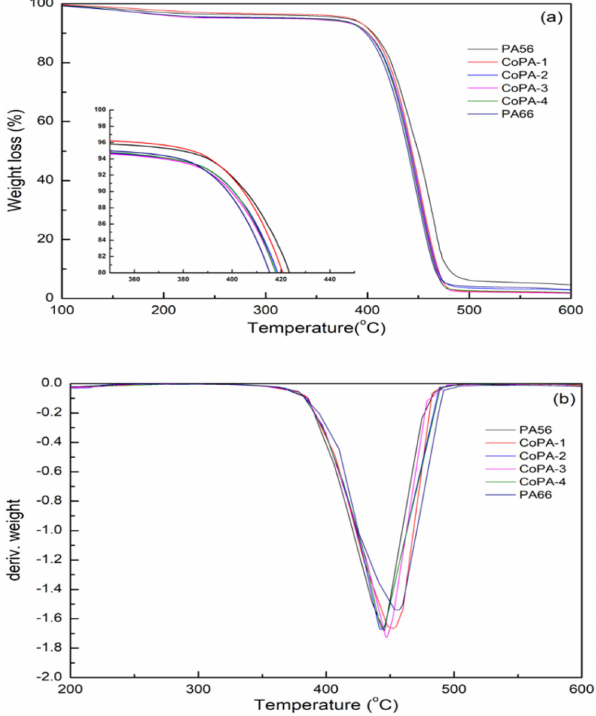
Figure 3. TGA ( a ) and DTG ( b ) curves of PA56/PA66 copolyamides with different comonomer